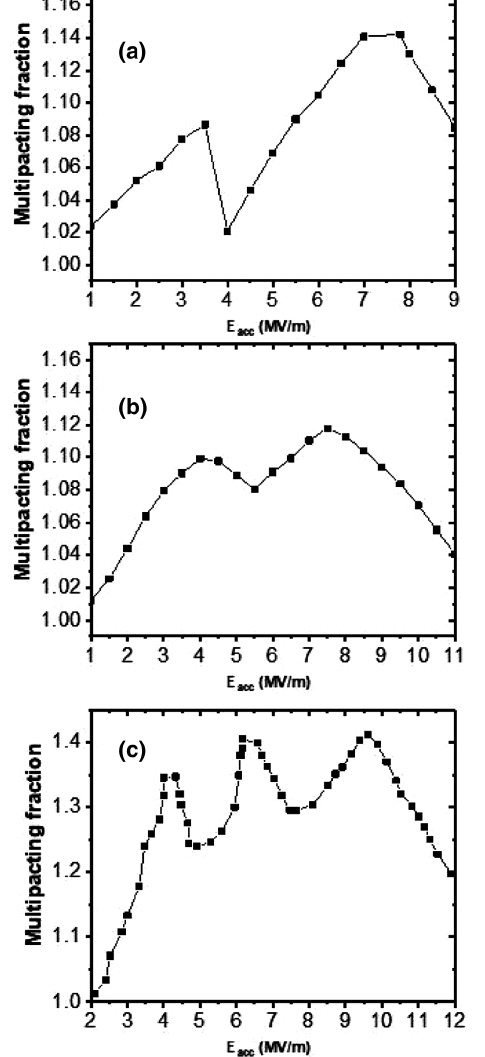
FIG. 30. Multipacting yield as a function of accelerating gradient for (a) SSR-A, (b) SSR-B, and (c) SSR-C.